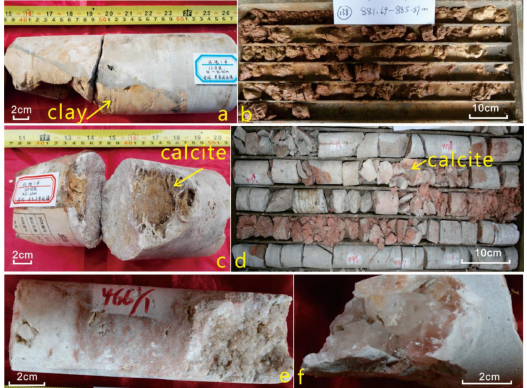
Figure 4. Characteristics of fillings in dissolution space. ( a ) Mud filling in caves, 46–46.46 m, HD1-4; ( b ) Caves filled with mud, 863–881 m, HD1-1; ( c ) Earthy yellow fine crystalline calcite growing in the cave wall, 421.05 m, HD1-4; ( d ) The cave calcite fillings infected by brick-red iron in the cave (1131–1138 m) of the HD1-4 well were speculated to be formed after the formation of white calcite dissolved by meteoric water in the later stage, and iron was oxidized to red. ( e ) Cave calcite fillings infected by brick-red iron in the cave, 1218 m; ( f ) Calcite of better crystal form growing in the hole, partly dyed brick-red, 1088 m,